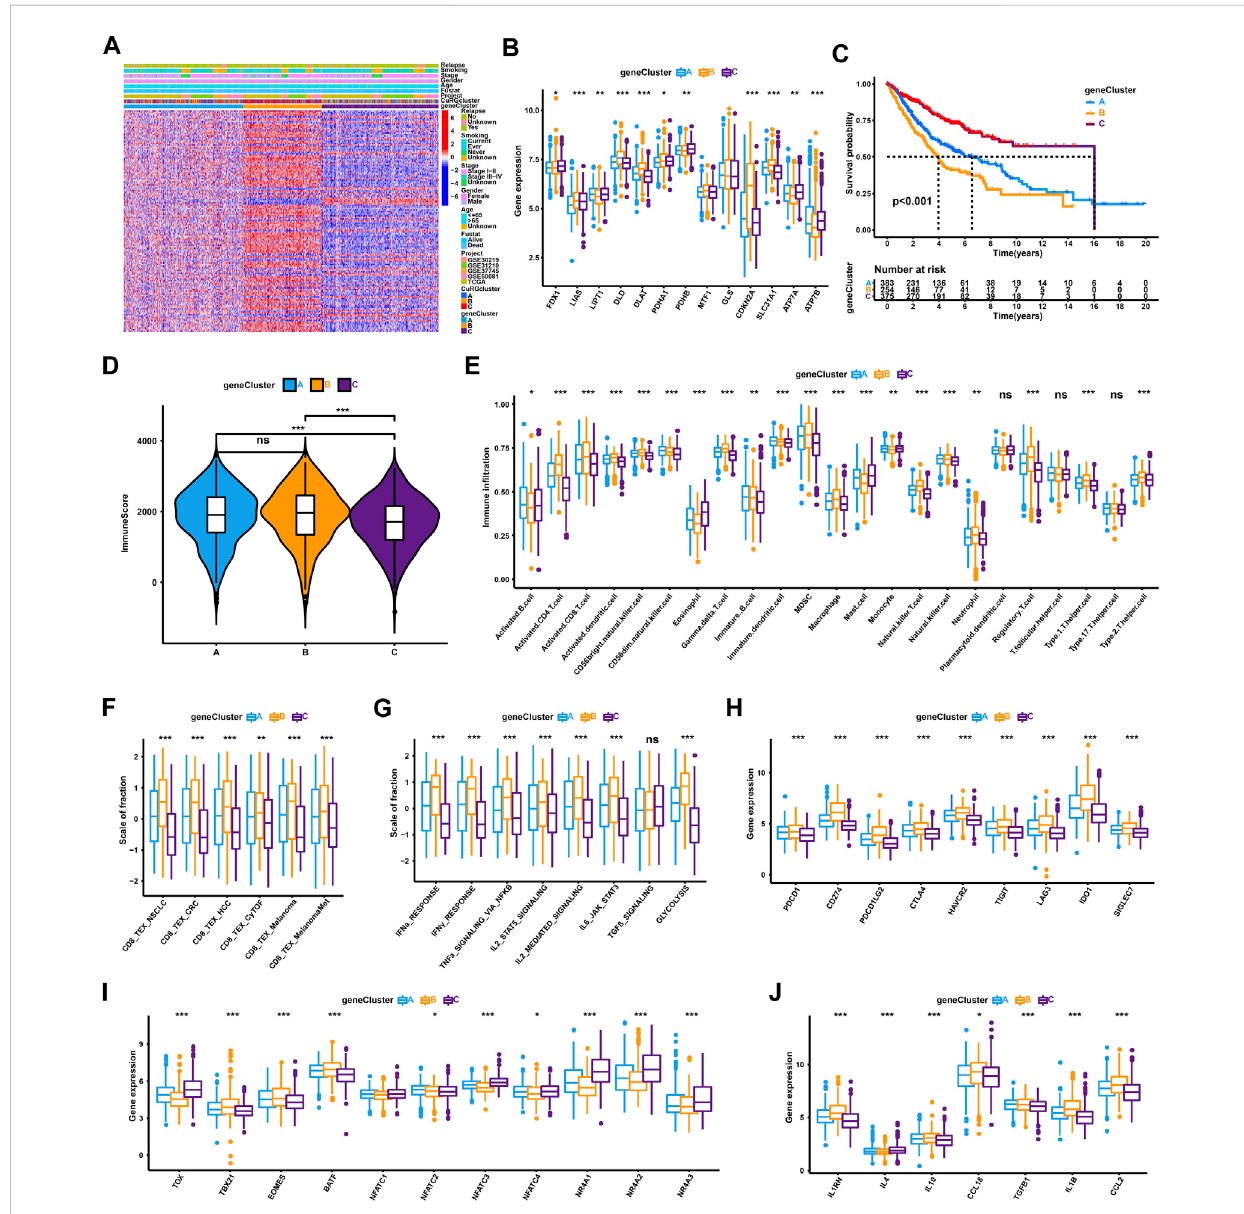
FIGURE 3 TEX and TIME characterization of the three geneClusters in LUAD. (A) Unsupervised clustering for 150 prognostic-related DEGs identi fi ed by univariate Cox regression classifying patients of training cohort into geneClusters A-C, respectively. The geneClusters, CuRGclusters, projects, tumor stage, survival status, relapse, smoking, gender, and age were used as clinical characteristics. (B) Expression of 13 cuproptosis genes in the three geneClusters. (C) Survival analyses for the three geneClusters based on 1,012 patients. (D) Immune score analyses using the ESTIMATE algorithm in thethree geneClusters. (E) The abundanceof eachTME in fi ltrating cell inthe threegeneClusters. (F – J) GSVA enrichment analysis between geneClusters A-C with TEX-related signatures (F) , signal pathways (G) , checkpoint genes (H) , transcription factors (I) , or in fl ammatory factors (J) . The line in the box represents the median value, and the asterisk represents the p -value. * p < 0.05; ** p < 0.01; *** p <